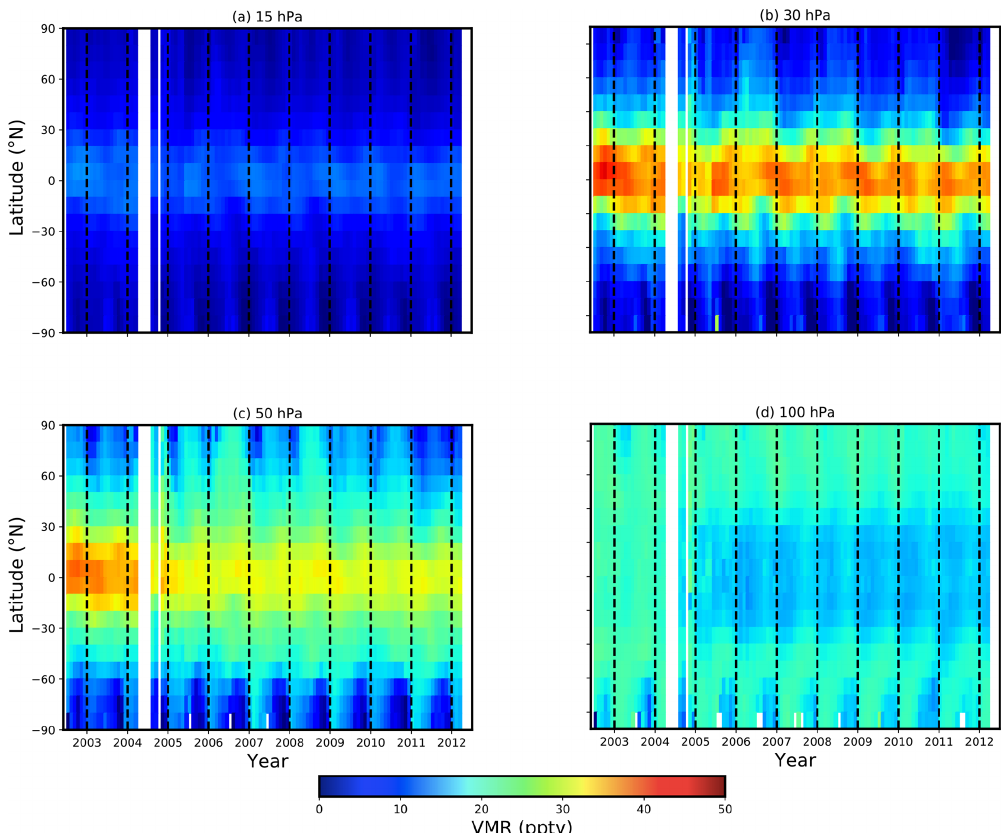
Figure 4. Time series of monthly mean COCl 2 VMR as a function of latitude (vertical scale). The four panels refer to different pressure levels: 15hPa (a) , 30hPa (b) , 50hPa (c) , and 100hPa (d) . The white areas denote periods of missing measurements. Labels on the x axis indicate the beginning of the years.